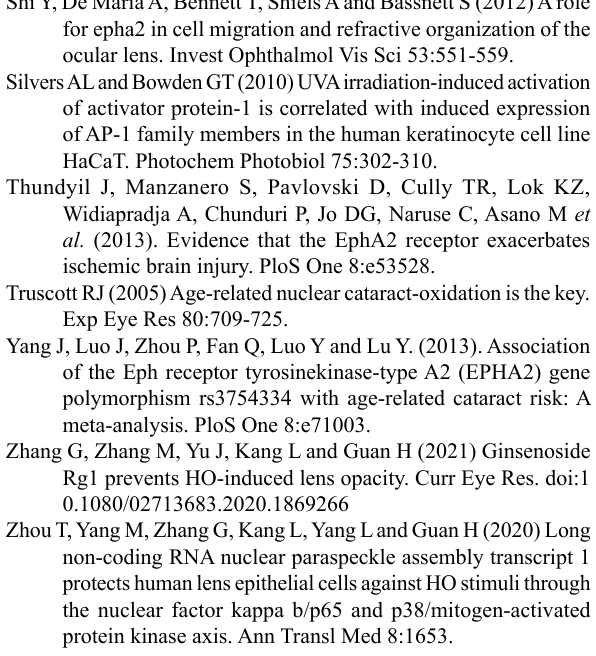
O -treated SRA01/04 cells. 2 2